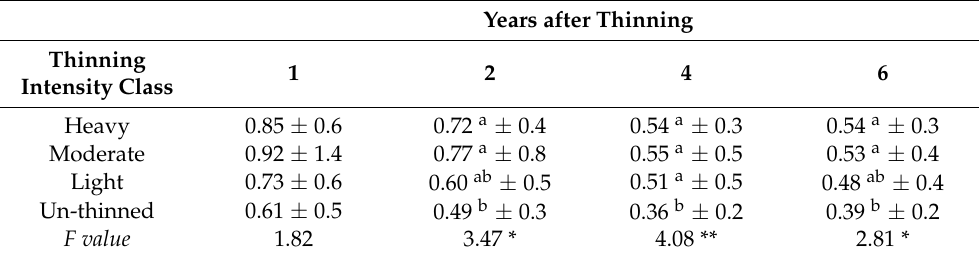
Table 3. Changes in diameter at breast height (DBH; cm) among different thinning treatments of Honduras mahogany of an age of 14 in the Guanmiao Farm in Guanmiao, Taiwan after thinning. Years after